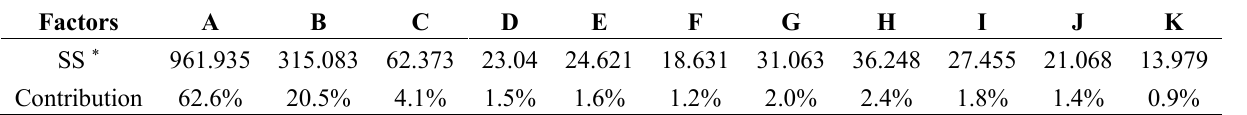
Table 3. Analysis of variance for the maximum local temperature-rise (MLT).